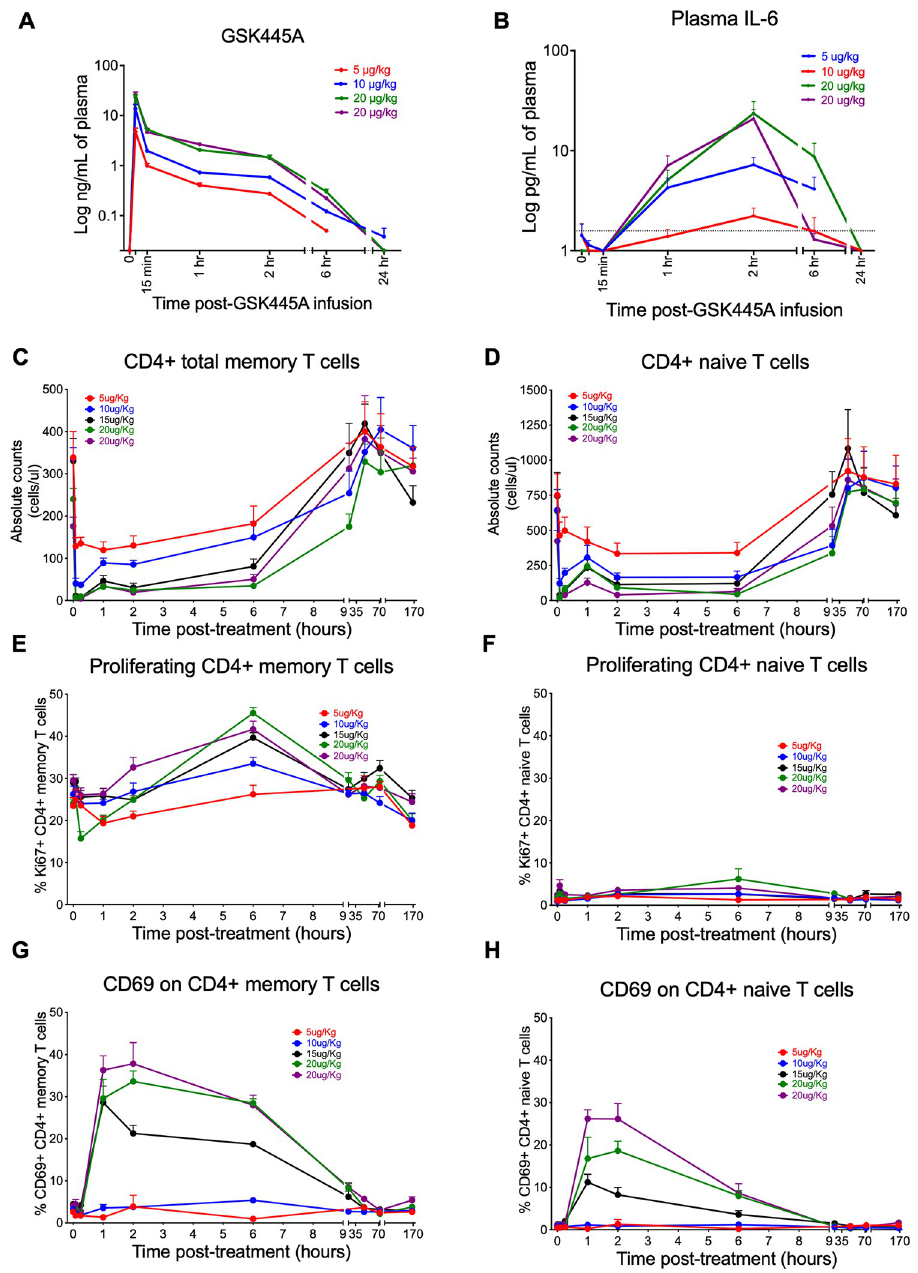
Fig 4. Effects of GSK445A on CD4 + T cell dynamics in SIV-naive RM. (A) Mean (+SEM) GSK445A drug levels in plasma of RM (n = 5) following 4 sequential intravenous infusions of GSK445A at 5 μ g/kg, 10 μ g/kg, 20 μ g/kg and 20 μ g/kg at 14-day intervals. (B) IL-6 levels in plasma of RM (n = 5) following sequential infusions of GSK445A. (C) Mean (+SEM) absolute counts of CD4 + memory T cells and (D) CD4 + naive T cells in blood of RM (n = 5) following sequential infusions of GSK445A at 5 μ g/kg, 10 μ g/kg, 20 μ g/kg, 20 μ g/kg and 15 μ g/kg at 14-day intervals. (E) Mean (+SEM) frequencies of Ki67 + CD4 + memory T cells and (F) Ki67 + CD4 + naive T cells in blood of RM (n = 5) following sequential infusions of GSK445A at 5 μ g/kg, 10 μ g/kg, 20 μ g/kg, 20 μ g/kg and 15 μ g/kg at 14-day intervals. (G) Mean (+SEM) frequencies of CD69 + CD4 + memory T cells and (F) CD69 + CD4 + naive T cells in blood of RM (n = 5) following sequential infusions of GSK445A at 5 μ g/kg, 10 μ g/kg, 20 μ g/kg, 20 μ g/kg and 15 μ g/kg at 14-day intervals.